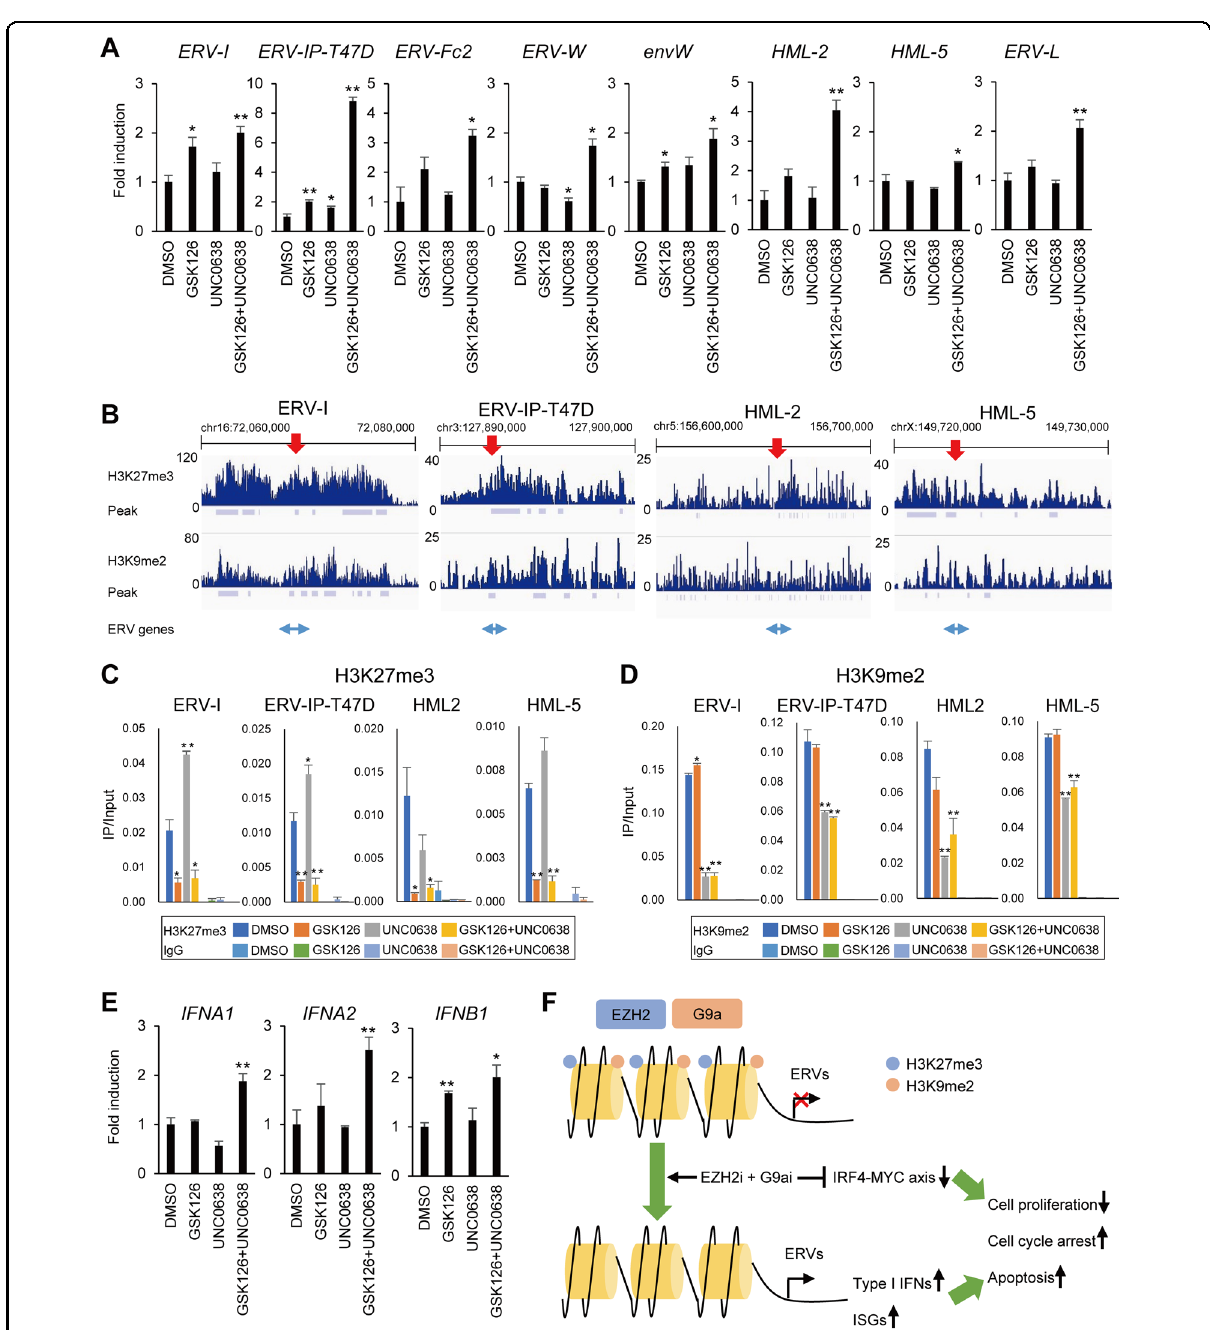
Fig. 5 Activation of ERV gene transcription by EZH2 and G9a inhibition in MM cells. A qRT-PCR analysis of ERV genes in RPMI-8226 cells treated with the indicated inhibitors (1 μ M each, 6 days). Results are normalized to cells treated with DMSO. Shown are means of three technical replications; error bars represent SEMs. B ChIP-seq analysis of ERV genes in RPMI-8226 cells. The numbers on the vertical axis indicate the numbers of sequence reads. Regions analyzed by ChIP-PCR are indicated by red arrows on the top, and the locations of ERV genes are indicated at the bottom. Peak, peaks detected by MACS2.0. C , D ChIP-qPCR analysis showing levels of H3K27me3 ( C ) and H3K9me2 ( D ) at ERV genes in RPMI-8226 cells treated with the indicated inhibitors. Results are normalized to respective input DNAs. Shown are means of three technical replications; error bars represent SEMs. E qRT-PCR analysis of interferon genes in RPMI-8226 cells treated with the indicated inhibitors. * P < 0.05, ** P < 0.01. F Hypothesized mechanism of the antimyeloma effect of EZH2/G9a inhibition.